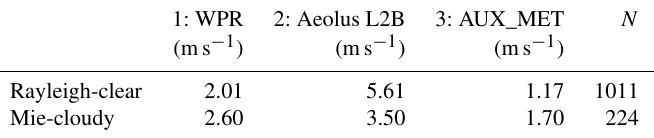
Table 4. Error standard deviation of three different